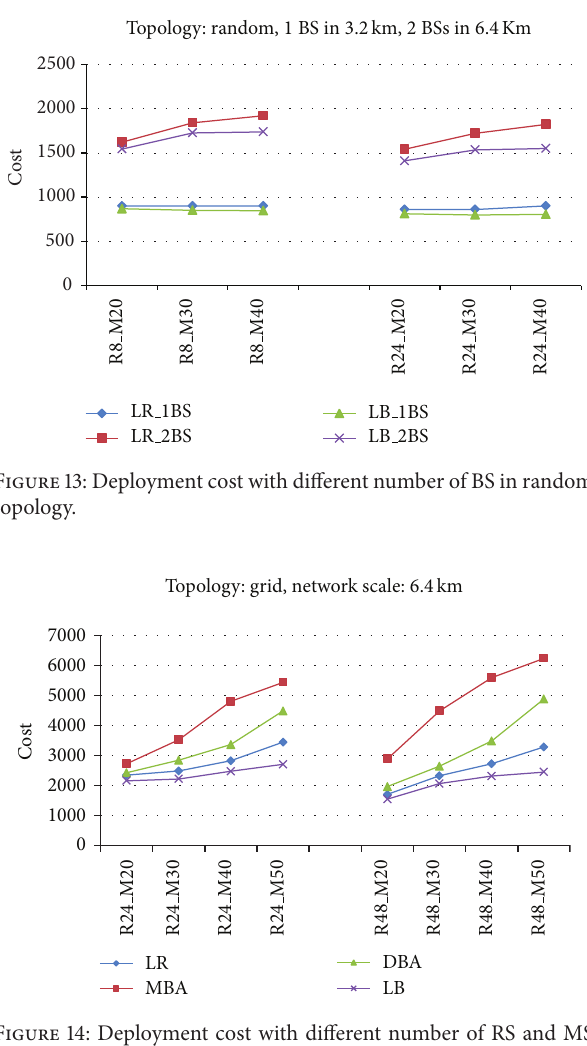
Figure 14: Deployment cost with different number of RS and MS (1BS, gird, 6.4 km).